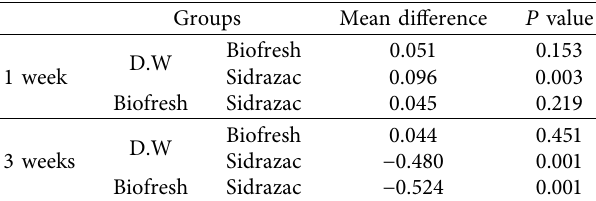
Table 2: Tukey HSD for each two groups of mouthwashes. Groups